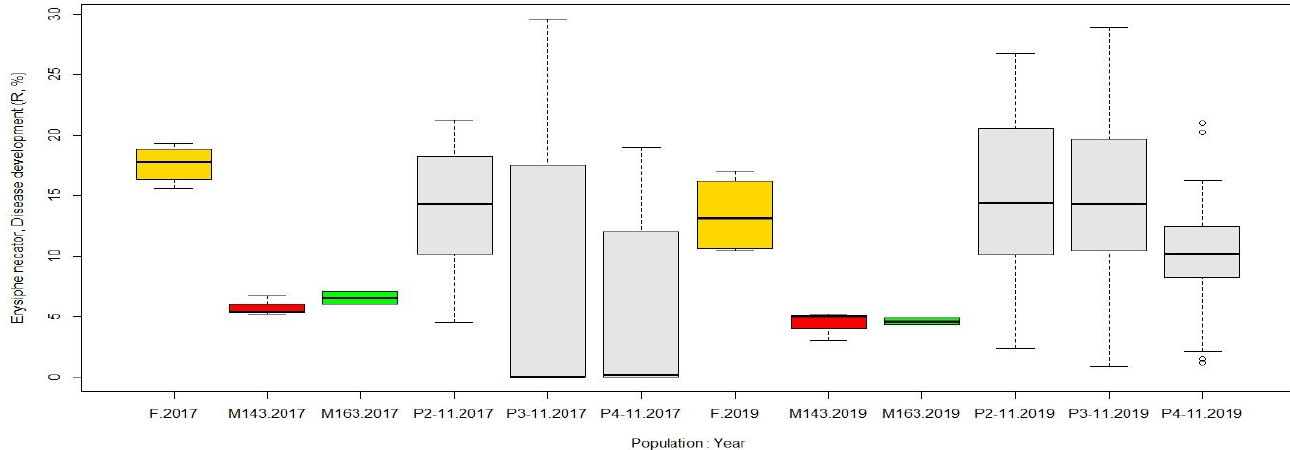
Figure 7. Resistance to powdery mildew (assessed as disease development score (R, %) per plant) of three hybrid populations (colored in light gray) and their parental genotypes (female M. No. 31-77-10, in yellow; male 2000-305-143, in red; male 2000-305-163, in green) under field natural conditions recorded in 2017 and 2019.